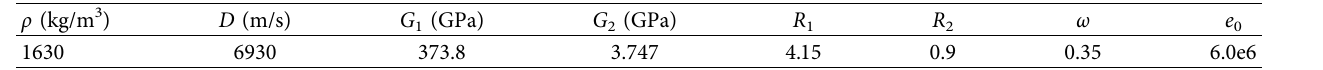
Table 1: JWL parameters for TNT charge.